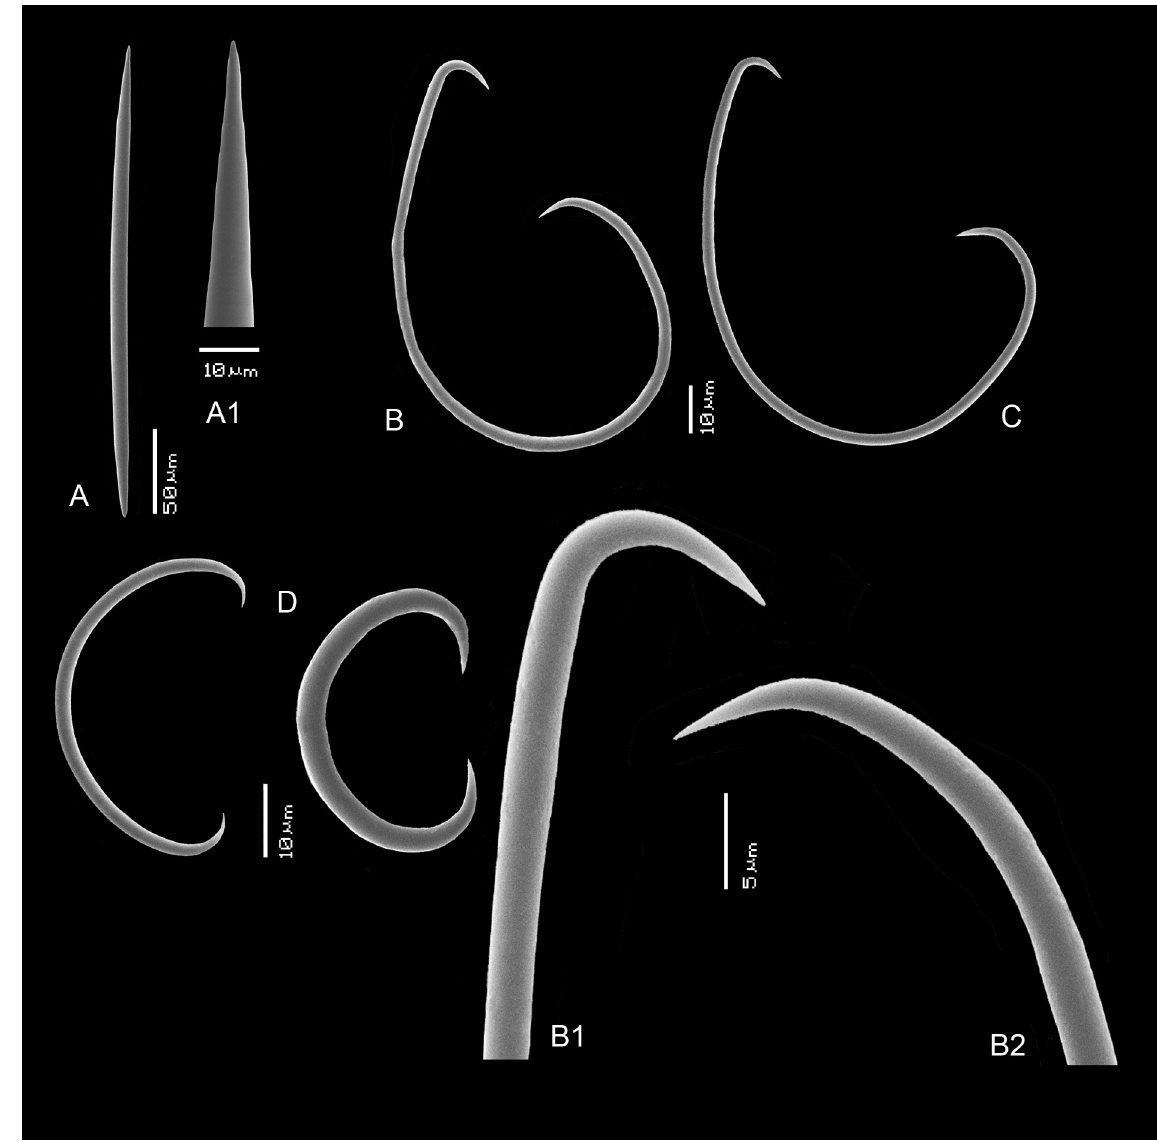
Fig. 17. Haliclona ( Flagellia ) sp., from Santa Marta, Colombia, SEM images of the spicules (ZMA Por. 21962). A . Oxea. A . Detail of one of the apices. B–C . Flagellosigmas. B 1 flagellosigma. B . Detail of short ending of flagellosigma. D . 2